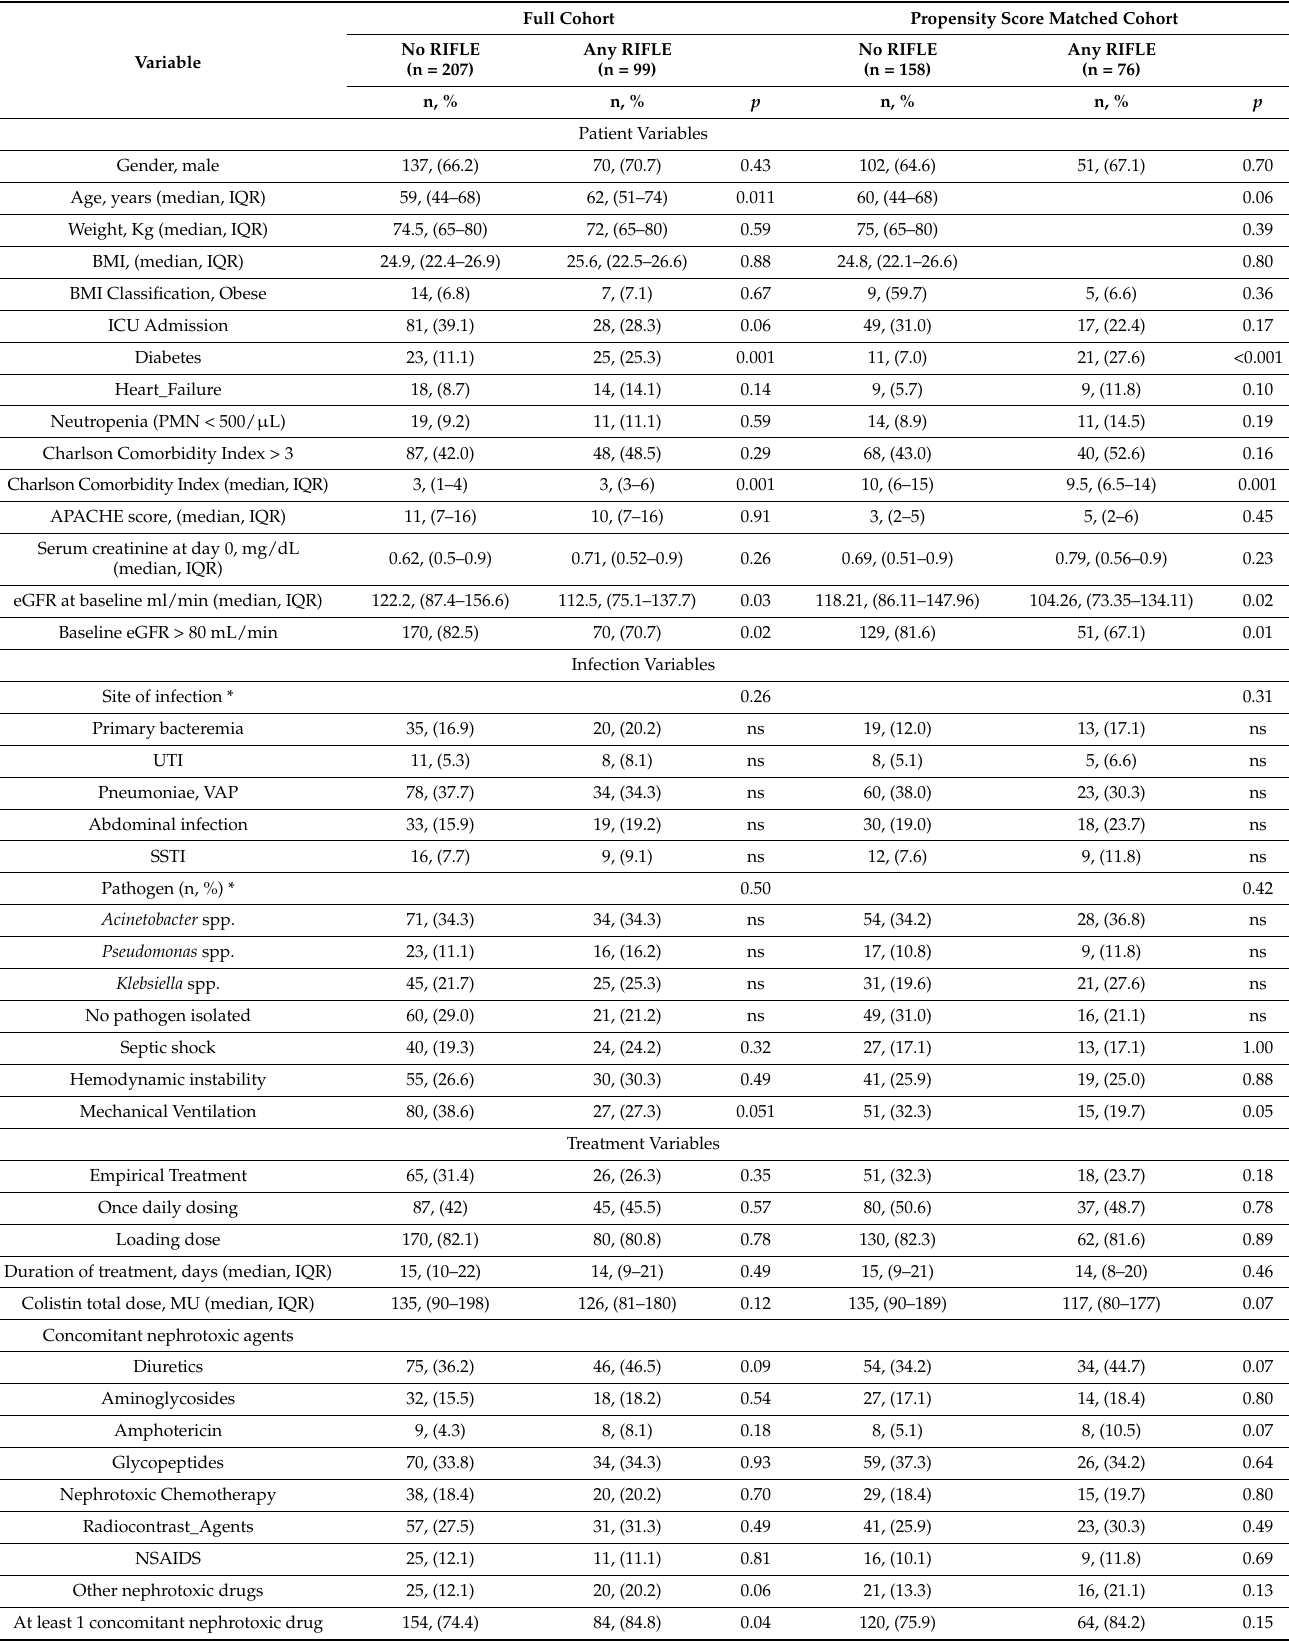
Table 3. Risk factors for nephrotoxicity–univariate